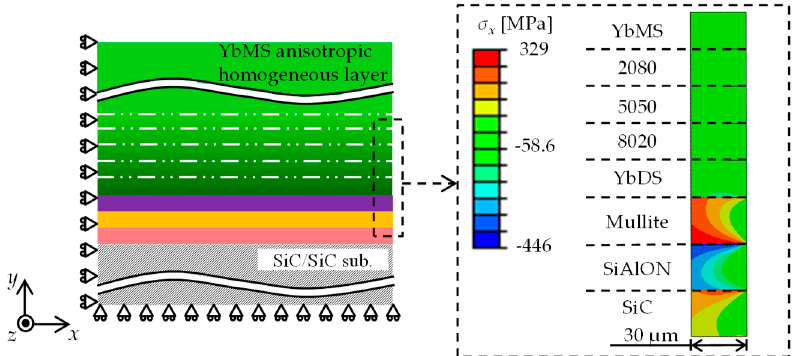
Figure A1. Thermal stress distribution near right interface edge of T / EBC deposited on SiC / SiC substrate without interface cracks.